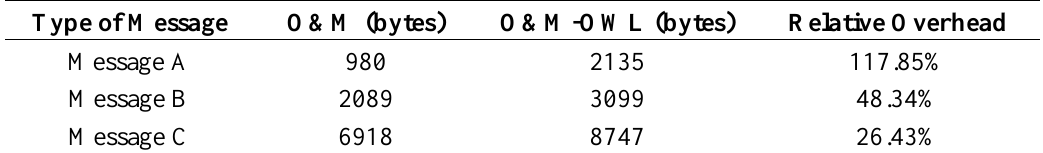
Table 1. Sizes and relative overhead for different message types including observations with semantic information (O&M-OWL) and without it